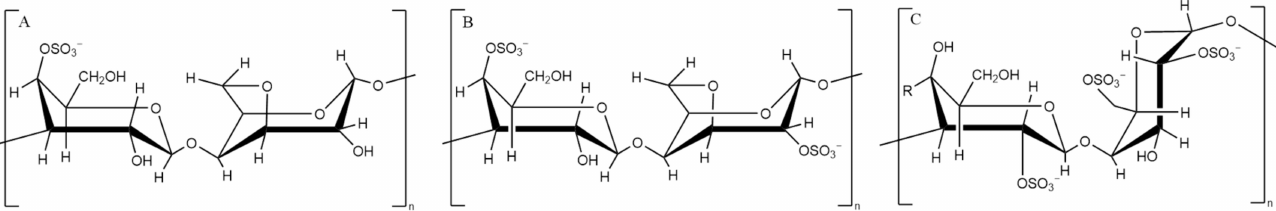
Figure 9. Chemical structure of carrageenan fragments (( A ) Kappa; ( B ) Iota; ( C )